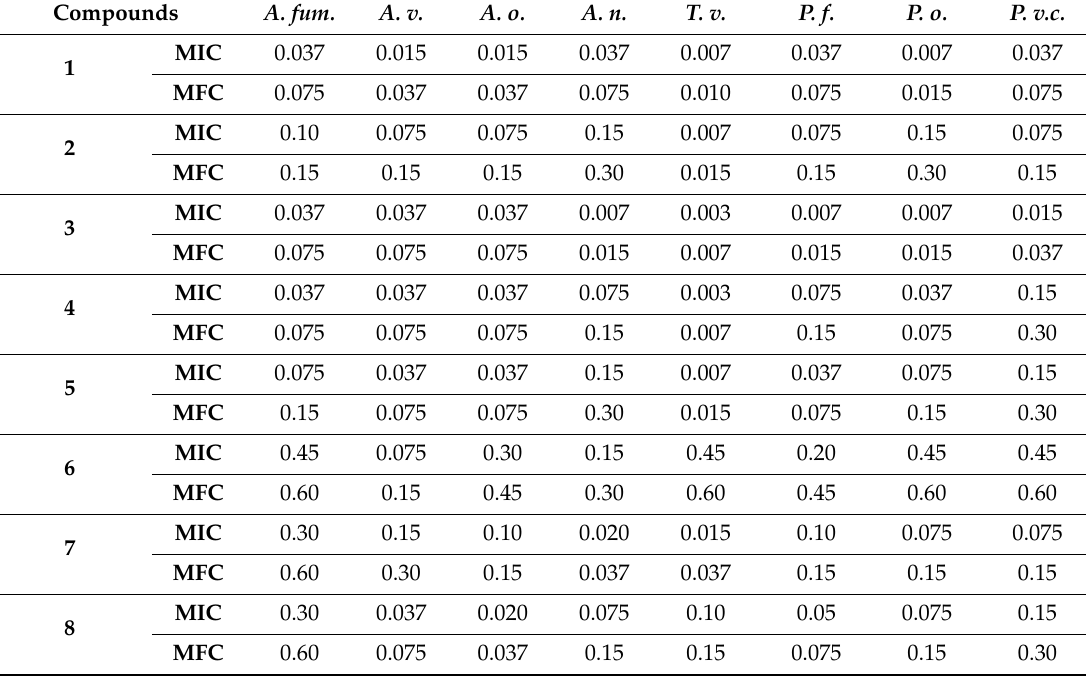
Table 4. Antifungal activity of compounds 10–31 (MIC and MFC in mg / mL).